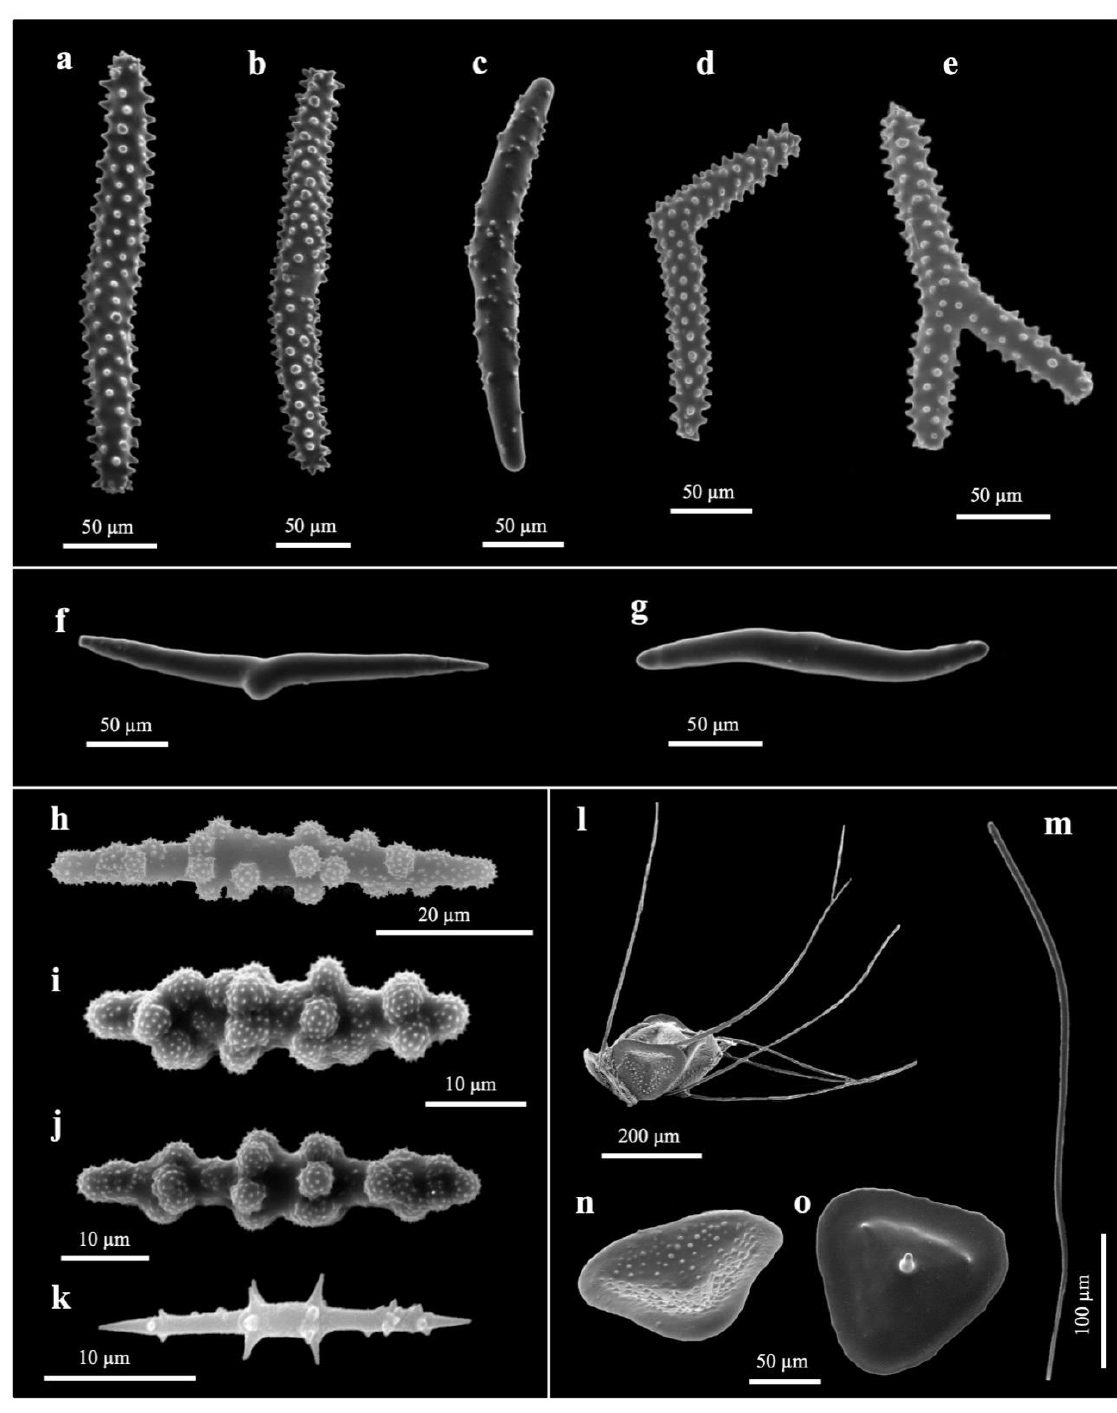
Figure 2. Spicule composition of Alectona millari. SEM images: ( a – d ) long acanthoxeas, with flattened spines scattered along the shaft; ( e ) acanthoxea showing a lateral ray, with a similar appearance to that of spined triactine; ( f , g ) curved, small, and smooth oxeas; ( h – k ) irregular spiny amphiasters; ( l ) armed larva; ( m ) thin sinuous style from larva surface; ( n , o ) outer and inner faces of the discotriaenes covering the larvae,